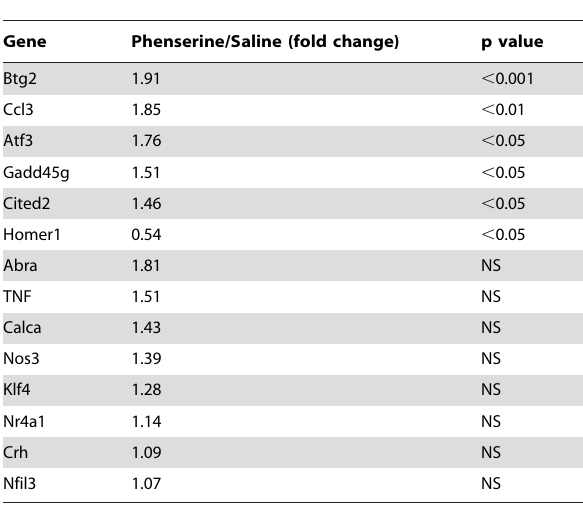
Table 3. Administration of ( 2 )-phenserine thirty minutes prior to soman differentially modulates gene expression in the piriform cortex three hours after